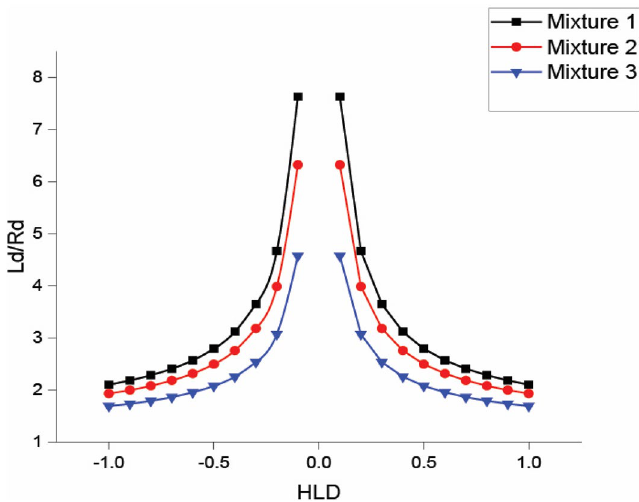
Figure 3. The ratio of cylindrical length to radius of microemulsion droplets ( L d / R d ) in the synthetic microemulsion system for all three mixtures predicted via the HLD-NAC